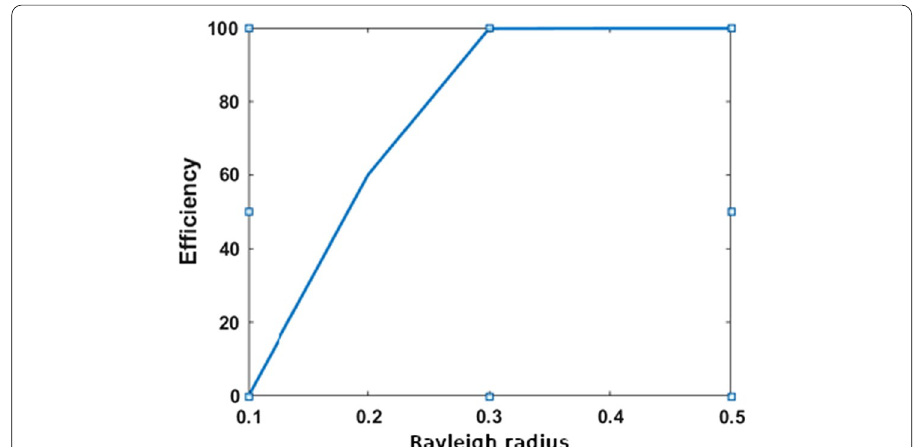
Fig. 5 Efficiency of the sheaf algorithm as a function of separation between two stars when the star count is known